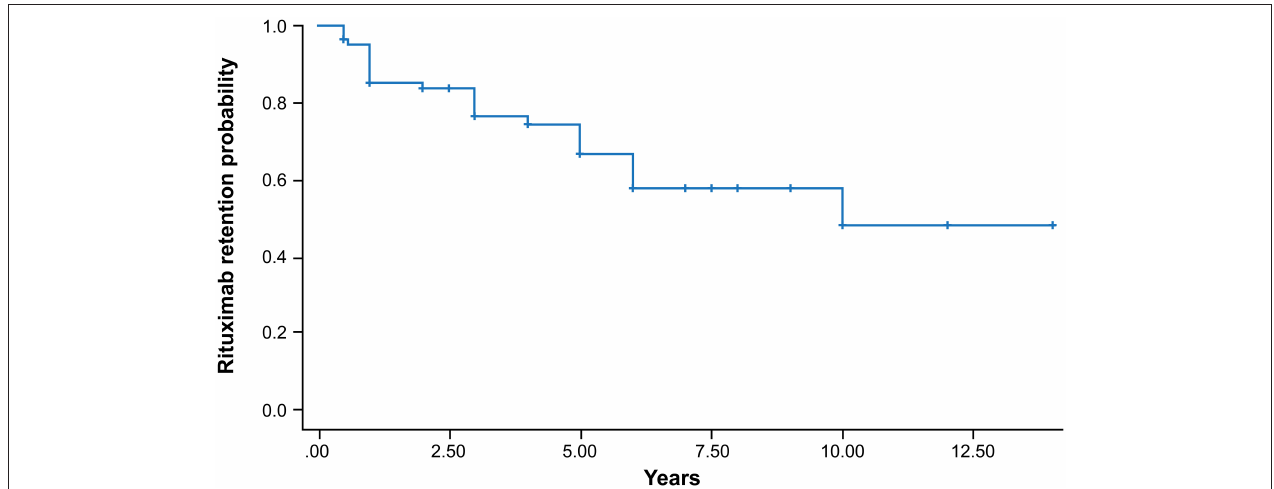
FIGURE 1 | Kaplan-Meier survival curve of the persistence of rituximab in patients with RA. The cumulative persistence rates were 97.5, 89.1, 84.8, 77.8, and 72.4% every year until 5 years after the first cycle of